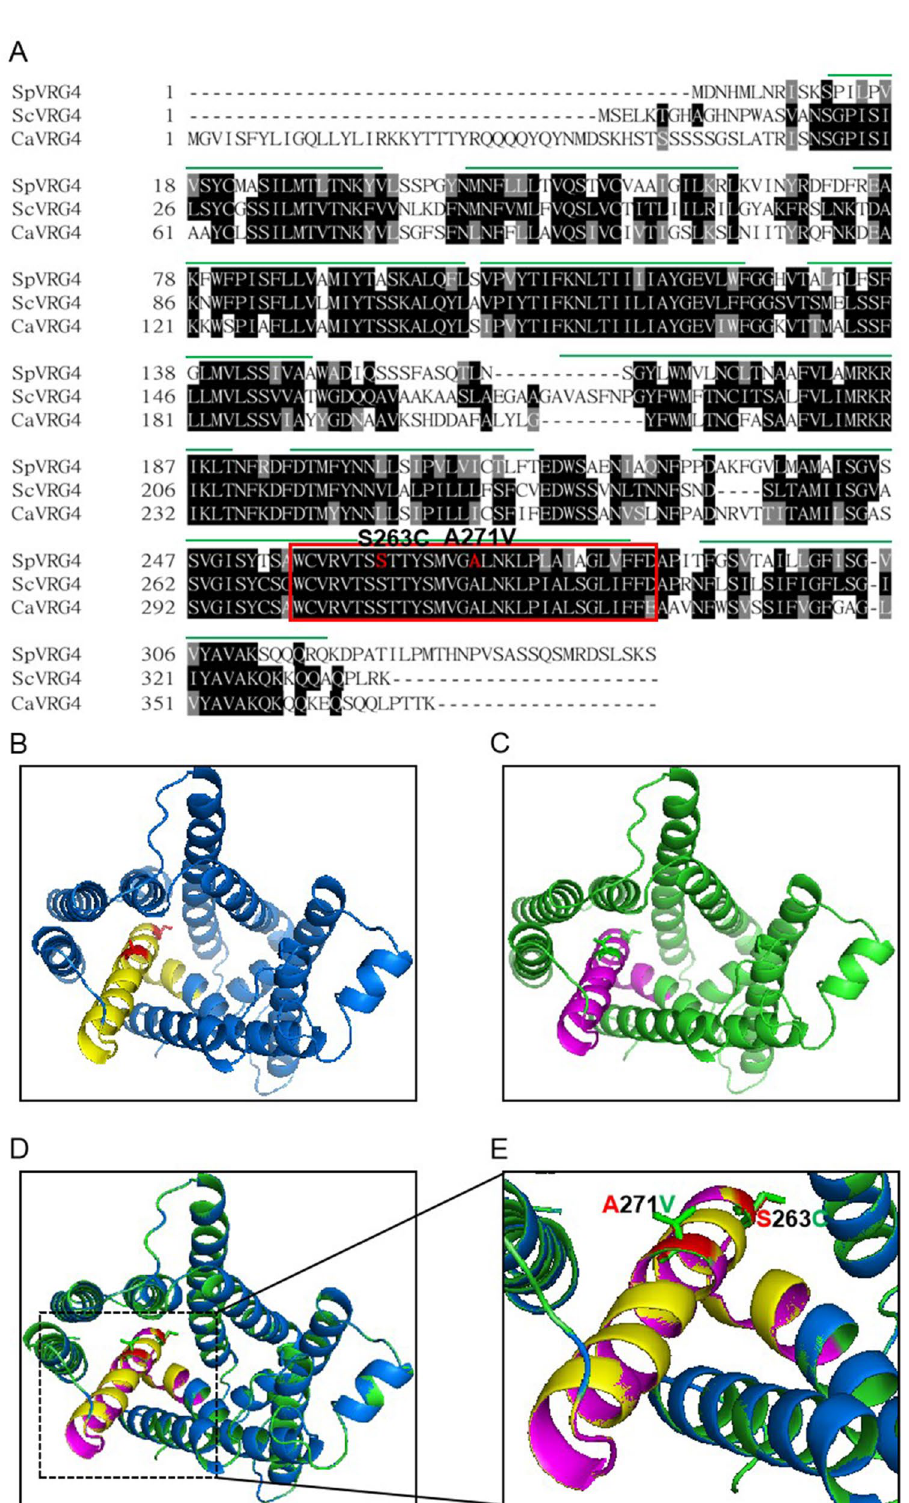
Figure 2. The S263C and A271V mutations had little effect on the overall structure of SpVrg4p. ( A ) Alignment of the Vrg4 protein sequences. The Vrg4 protein sequences of S. cerevisiae, S. pombe and C. albicans were aligned in CLUSTALW. The red orthogon indicates the reported nucleotide sugar-binding motif in ScVrg4p. The green lines represent the transmembrane helices in ScVrg4p. The mutation sites 263 and 271 are shown in red. ( B )–( E ). Golgi lumenal view of Vrg4p structures. WT ( B ), mutant ( C ), structural alignment ( D ) and closed views of aligned nucleotide sugar-binding motifs ( E ) are shown. The structure of mutant SpVrg4p was obtained from homologue modelling using Swiss-Model following the Alignment Mode procedure and structurally aligned with WT Vrg4p via TM alignment. The nucleotide sugar-binding motif is shown as yellow in the WT and magenta in the mutant protein. The mutated residue sites are shown in stick